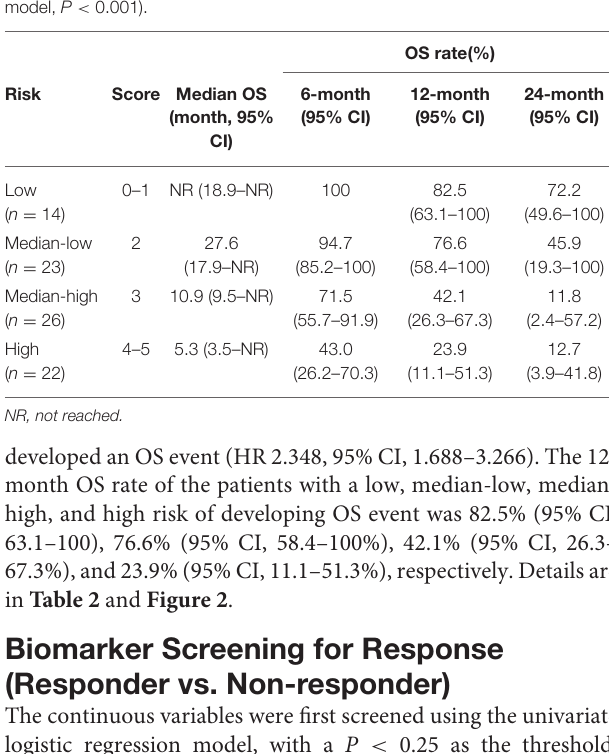
dNLR ( P = 0.17), monocyte ( P = 0.18), and WBC ( P = 0.20). A TABLE 2 | Risk model for OS (univariate Cox proportional hazard regression model, P <